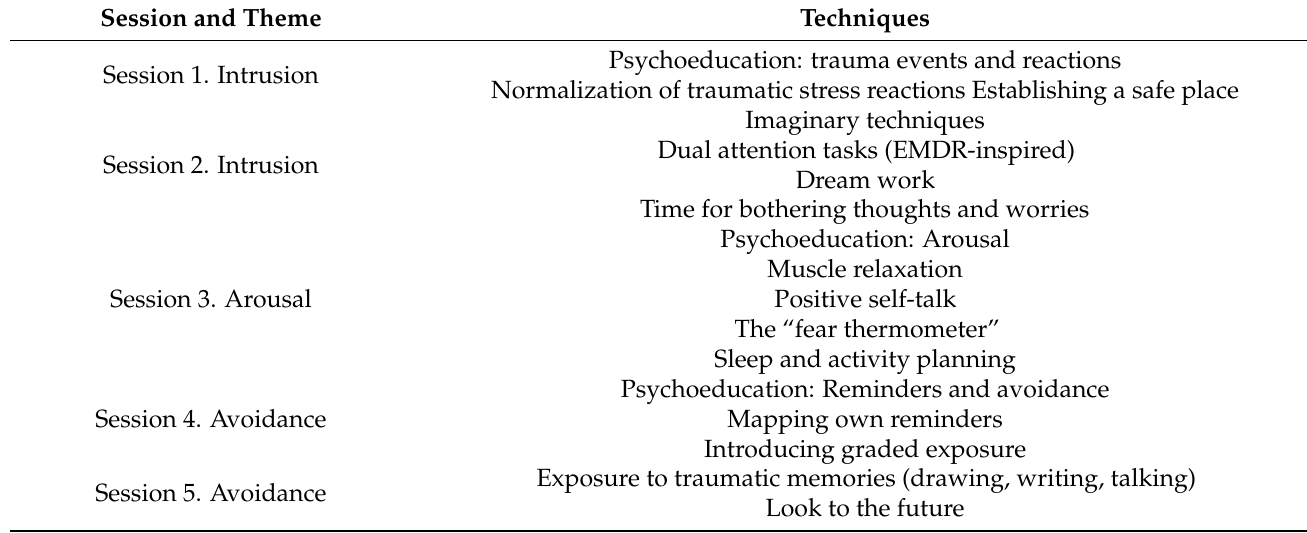
Table 1. Content of the Teaching recovery techniques (TRT) programme: the 5 child sessions. Session and